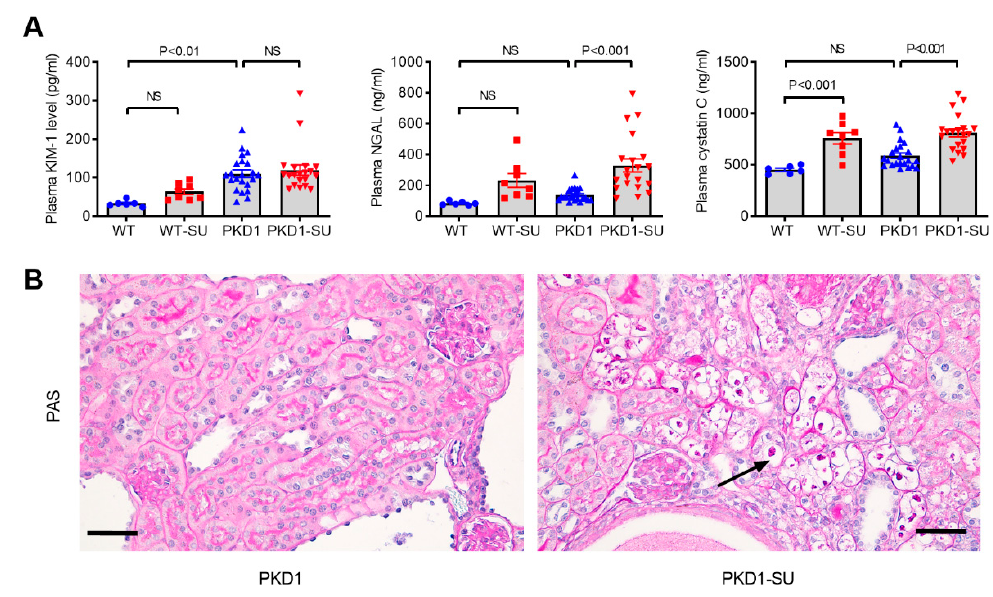
Figure 7. Suramin induces cytoplasmic vacuolation and kidney injuries in non-cystic tubules. ( A ) Plasma levels of kidney injury markers (KIM-1, NGAL, cystatin C) were increased in the suramin- treated Pkd1- miR Tg mice compared to the vehicle-treated mutant mice. Data are mean ± SEM (n = 6, 8, 22, and 20 per group respectively). ( B ) Representative periodic acid-Schiff (PAS) staining in the kidney sections from the vehicle- and suramin-treated Pkd1 -miR Tg mice (n = 3 per group). Arrow indicates the cytoplasmic vacuolation and degeneration of proximal tubules. Scale bar, 50 µm.